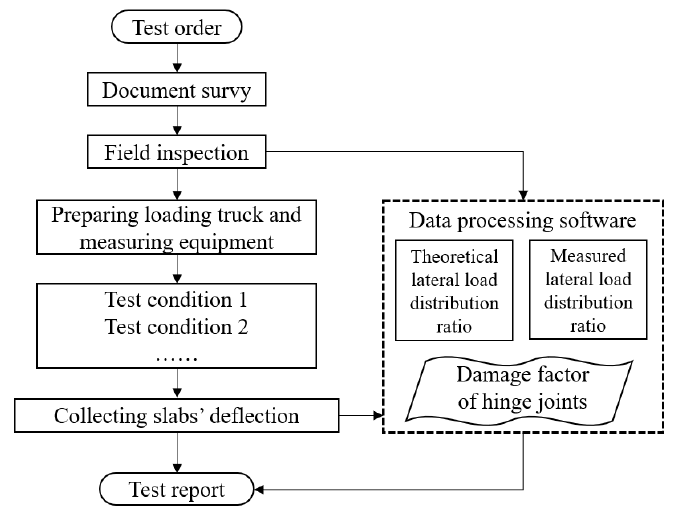
Figure 3. Flow chart of the light-load field test.